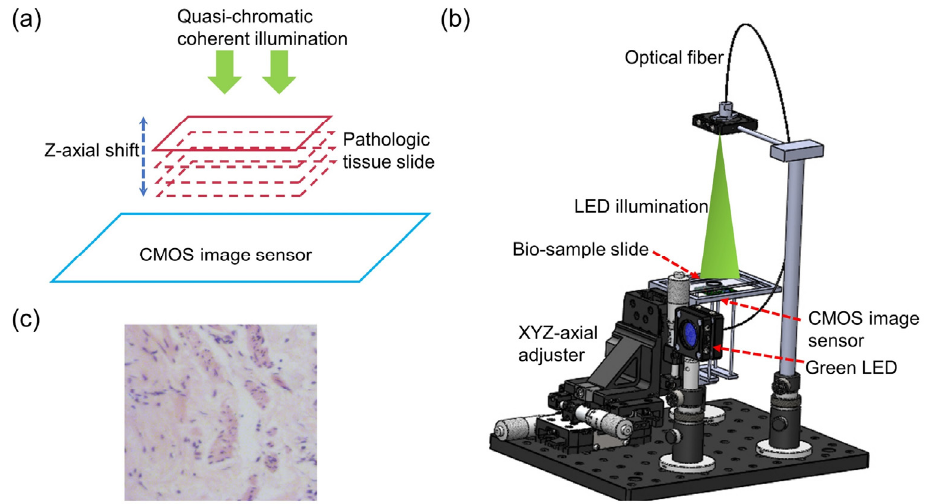
Figure 2. Typical schematic of lens-less diffraction microscopy setups based on multiple holograms: ( a ) the principal schematic; ( b ) a 3D mechanical design of a lens-less diffraction microscope; ( c ) typical H&E stained pathological slide [57].